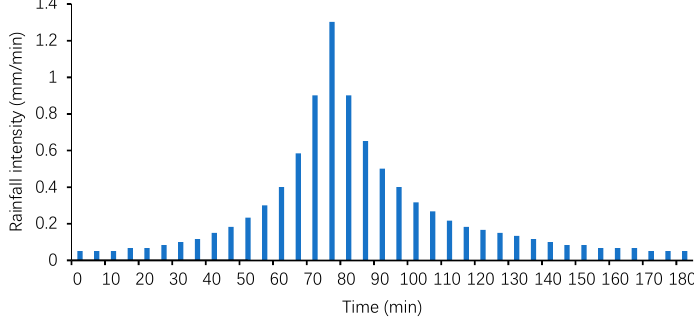
Figure 4. Design hyetograph when the return period was taken as 80%.